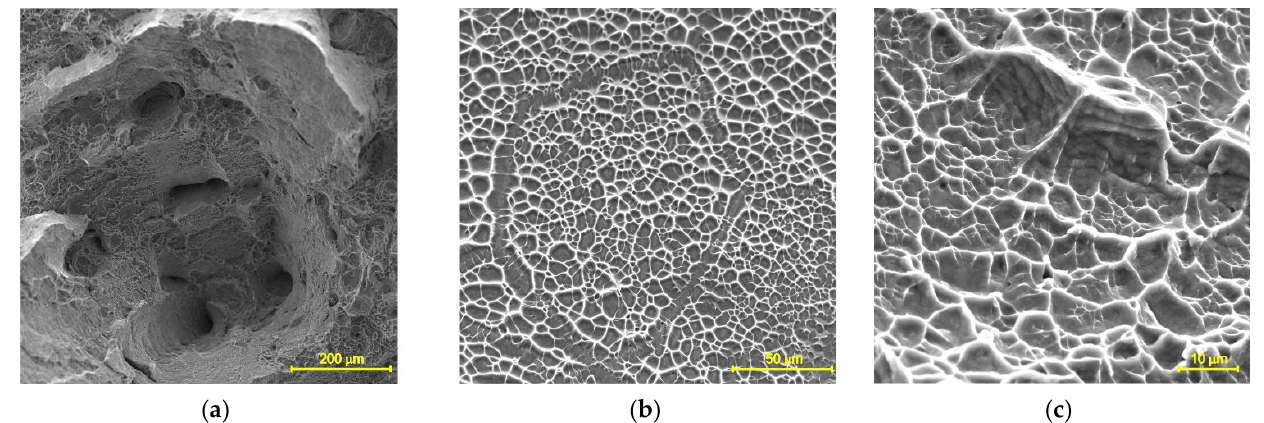
Figure 8. SEM fractograph of a specimen tested at 200 °C showing ( a ) the fibrous central zone and ( b , c ) the shear zone.